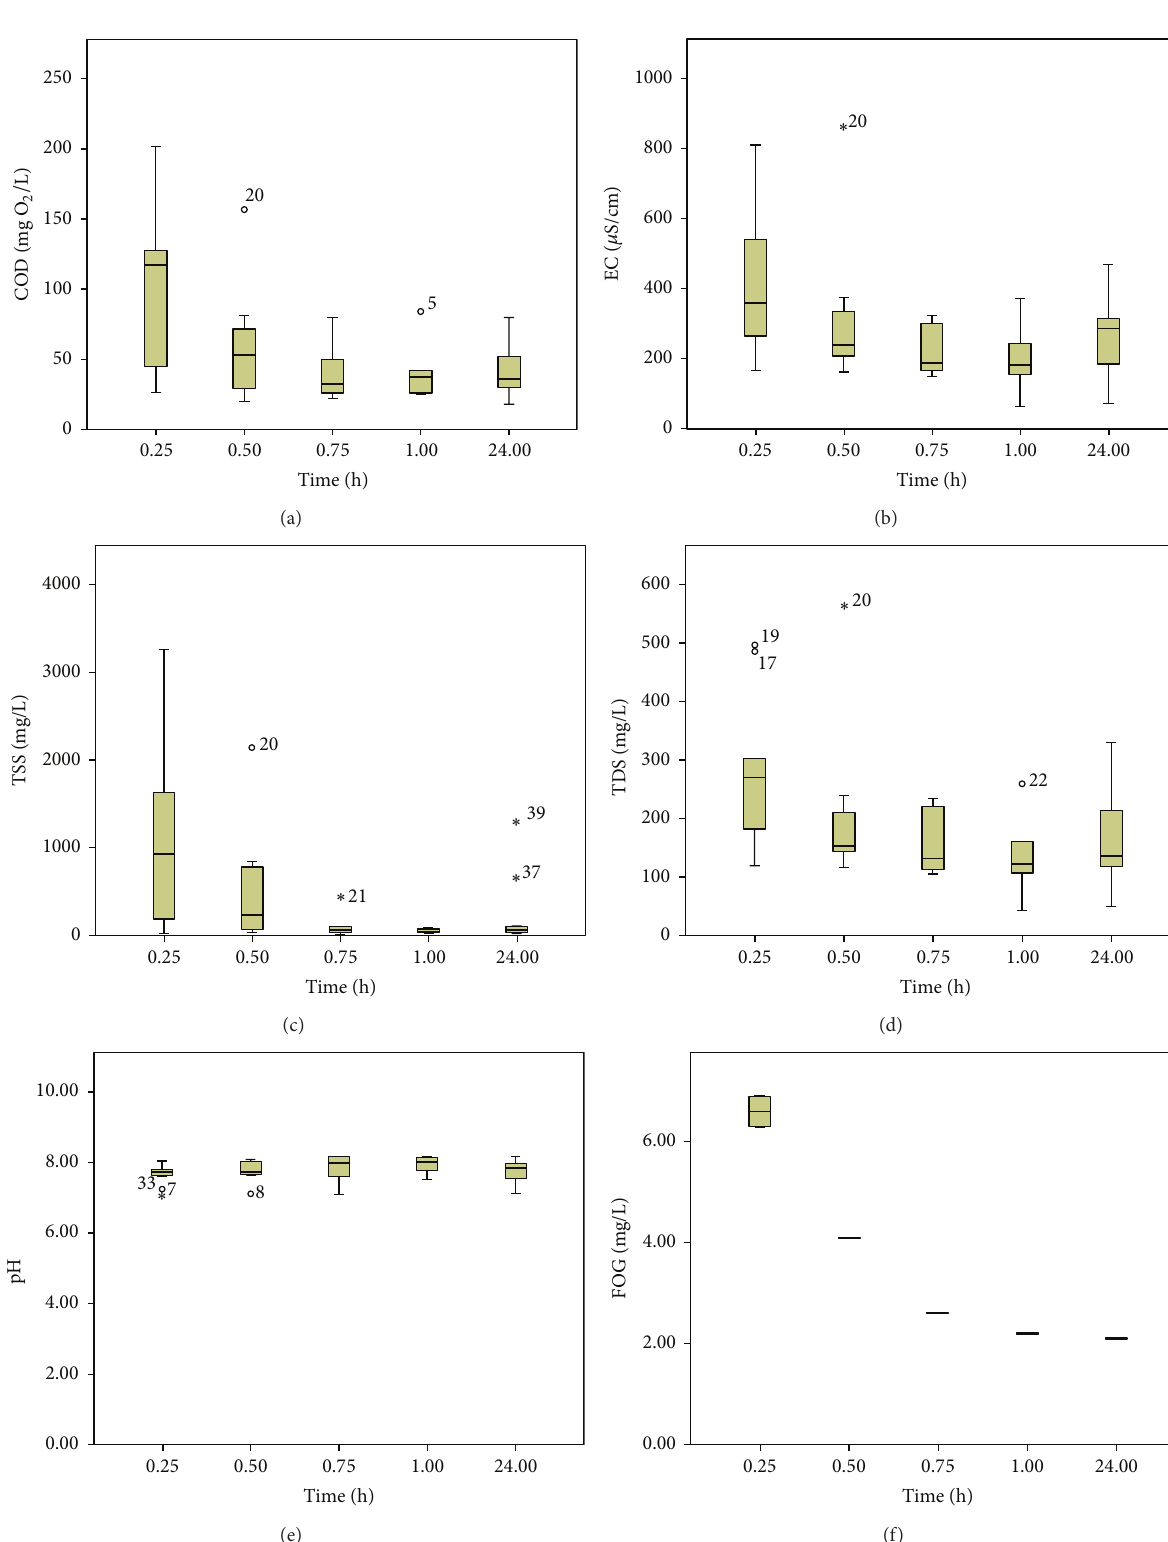
Figure 2: Micropollutant (COD, EC, TSS, TDS, pH, and FOG) variations in runoff samples without the first flush sample in Area A (but with the 50 samples per sampling